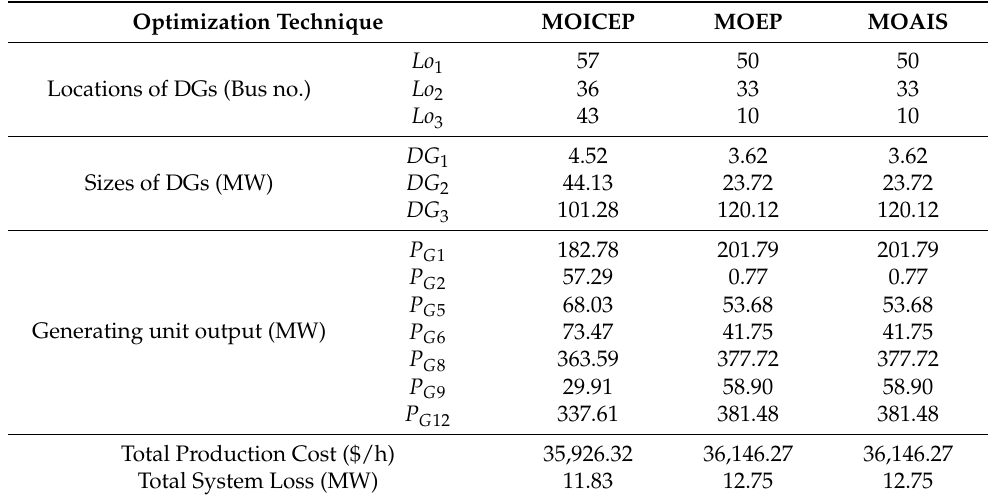
Table 13. Results of the integrated ED problem with prohibited operating zones and DG installation of the IEEE 57-Bus RTS ( w 1 = 0.5 and w 2 = 0.5). Optimization Technique MOICEP MOEP MOAIS Lo 1 Locations of DGs (Bus no.)